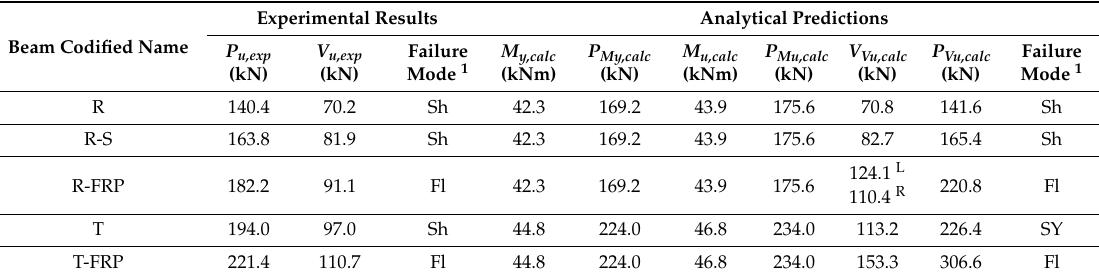
Table 1. Summary of the experimental and analytical results of the tested beams.